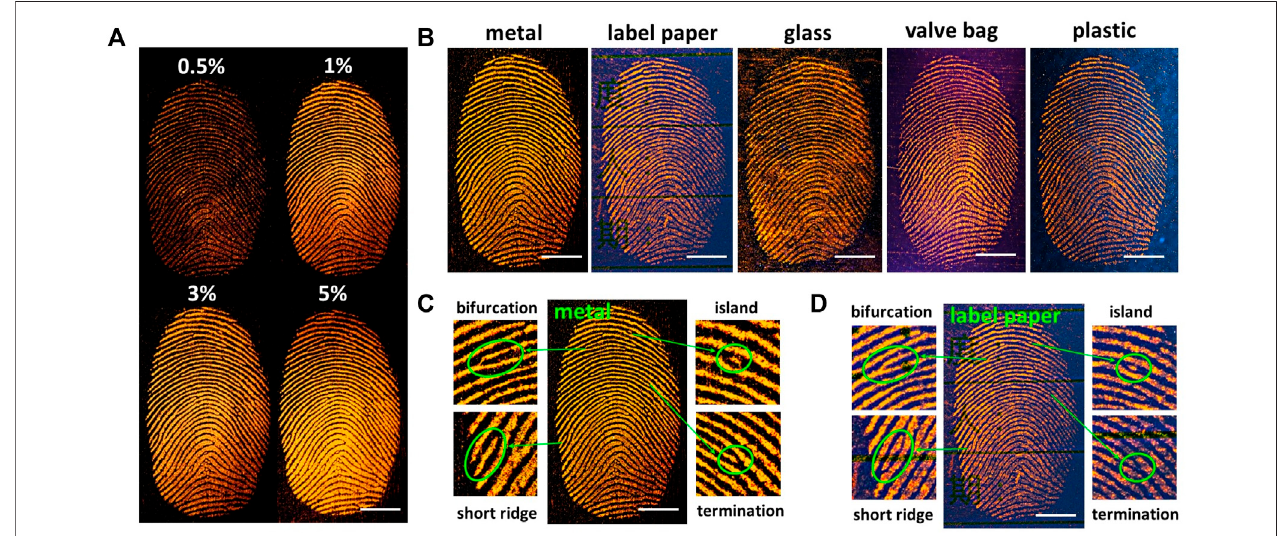
FIGURE 2 | (A) Images of LFPs developed by the mixing powder of Boc-PZ-DCM/MMT with dye content of 0.5%, 1%, 3%, 5%, respectively, under 365 nm irradiation. (B) ImagesofLFPsondifferentsubstratesdevelopedbythemixingpowderofBoc-PZ-DCM/MMTwithdyecontentof3%. (C) Level2detailsofLFPonmetal developedbythemixingpowderofBoc-PZ-DCM/MMTwithdyecontentof3%. (D) Level2detailsofLFPonlabelledpaperdevelopedbythemixingpowderofBoc-PZ- DCM/MMT with dye content of 3%. Scale bar, 5